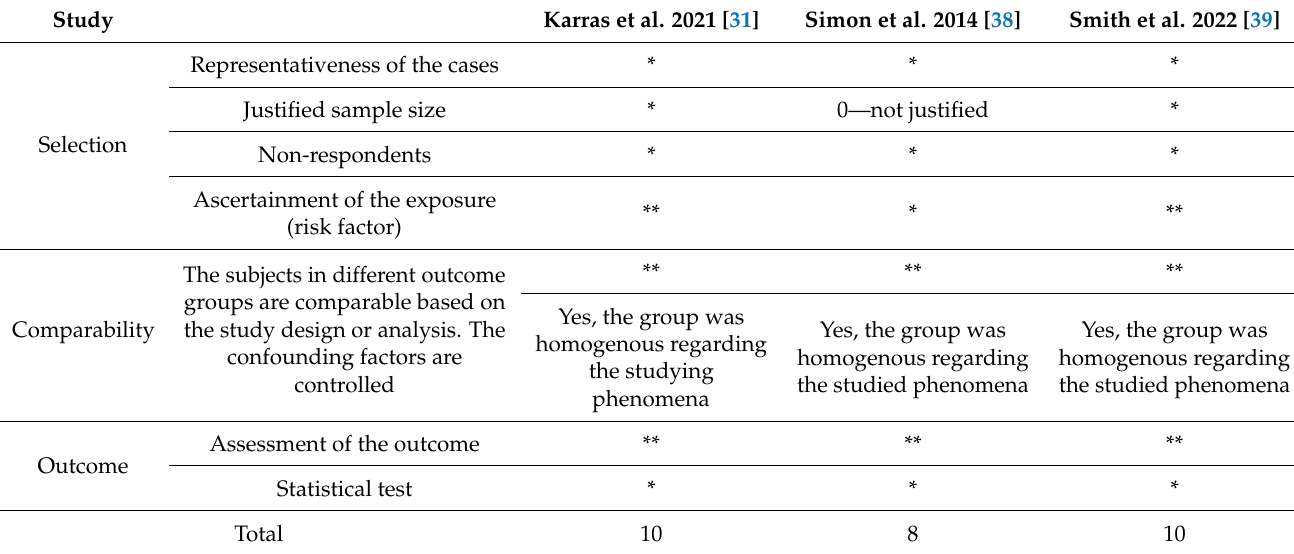
Table 6. Newcastle–Ottawa Quality Assessment Form for Cross-Sectional